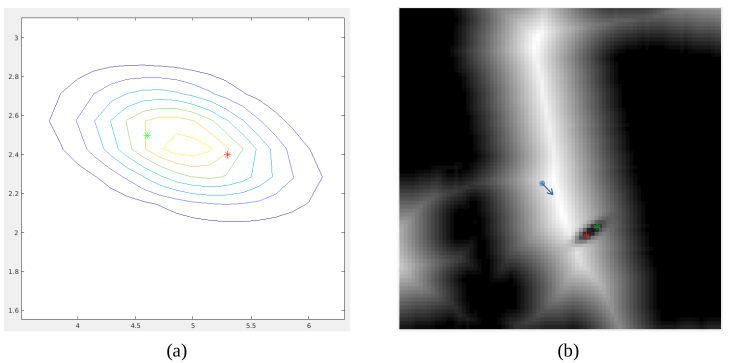
Figure 26. Detection and modeling of a group: ( a ) Gaussian model, in meters, defined in the robot reference frame, ( b ) inclusion of the Gaussian model in the velocity map using the map reference